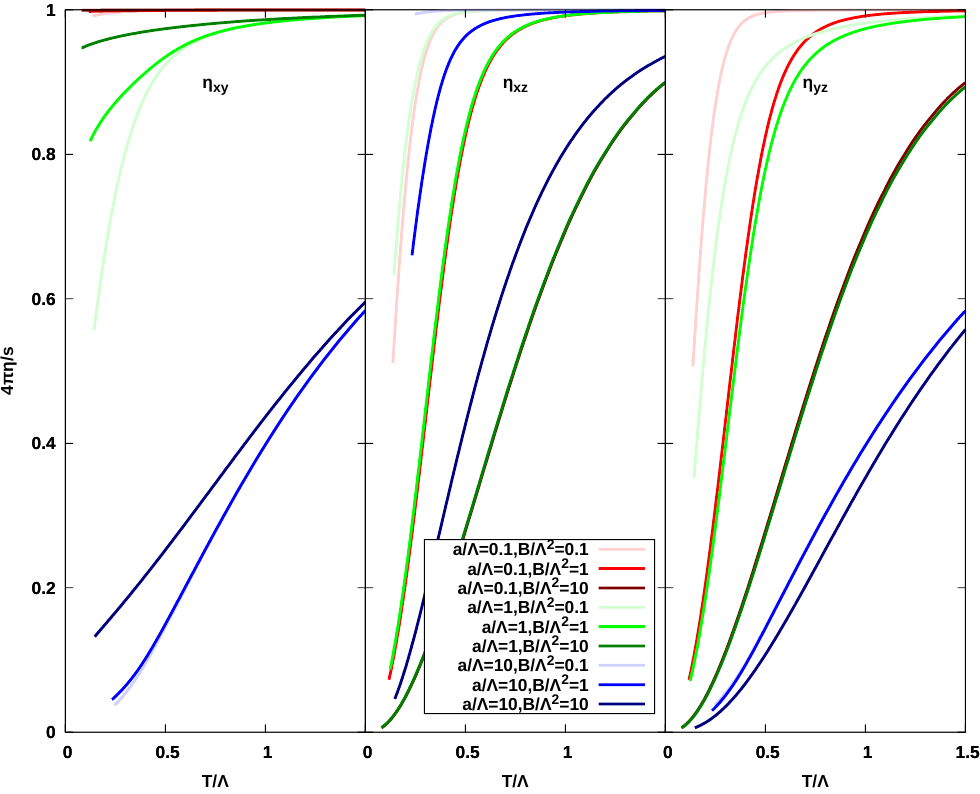
Figure 6 . Ratio between the components of the shear viscosity tensor and the entropy density in the chirally symmetric phase for the case where the magnetic field (aligned along the z -direction) is perpendicular to the anisotropic deformation (introduced along the y -direction). All the plots are given as a function of temperature (in units of Λ ∼ 1 GeV) and correspond to c = 0 . 25 . Furthermore, the curves are cut off at the chiral transition temperature so they correspond to the chirally symmetric phase. In all cases, we observe a monotonic flow from η to a lower, non-zero value in the IR, before the transition kicks in. We observe a clear distinction in behaviors among the different components: i) The magnetic field B raises η η yz . ii) The anisotropic parameter a lowers η xy and η yz and raises η xz . And iii) B affects